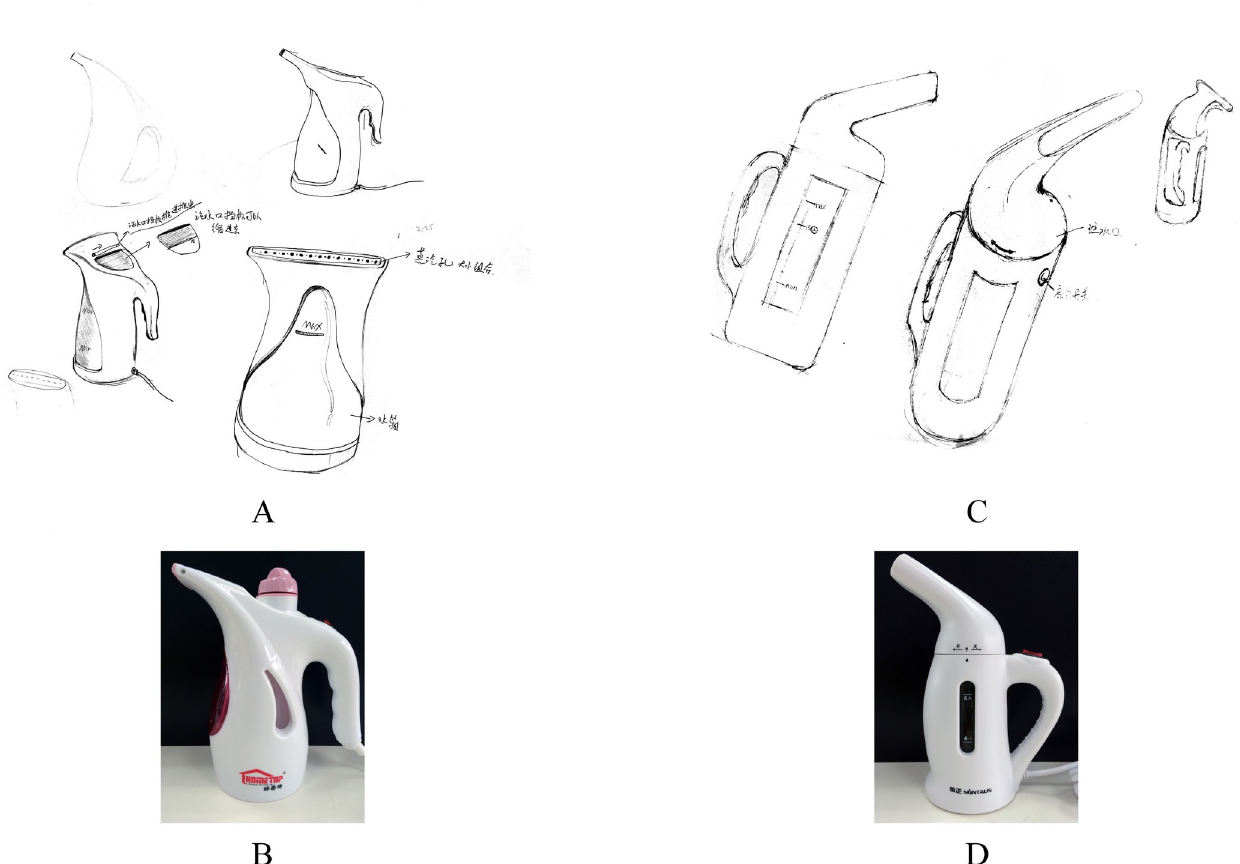
Fig 3. Comparison of the Examples and Designs with High Similarity in the Integral Shape Evaluation (A: A design submitted from physical group; B: Design example 1; C: A design submitted from pictorial group; D: Design example 3).